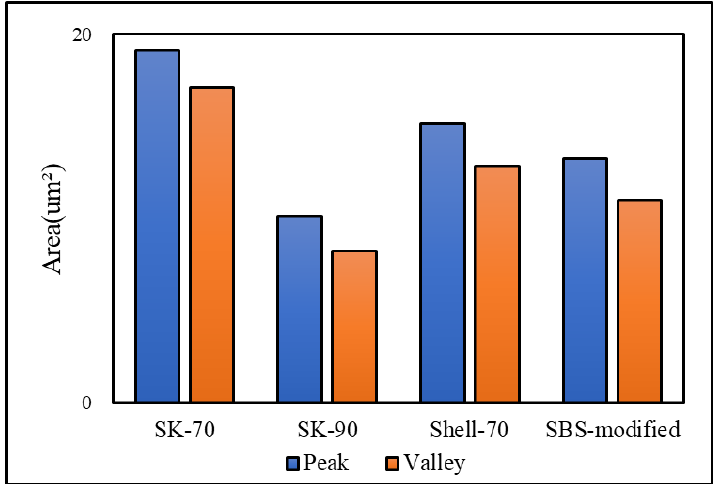
Figure 11. The area of bee-like structure in aged asphalt.